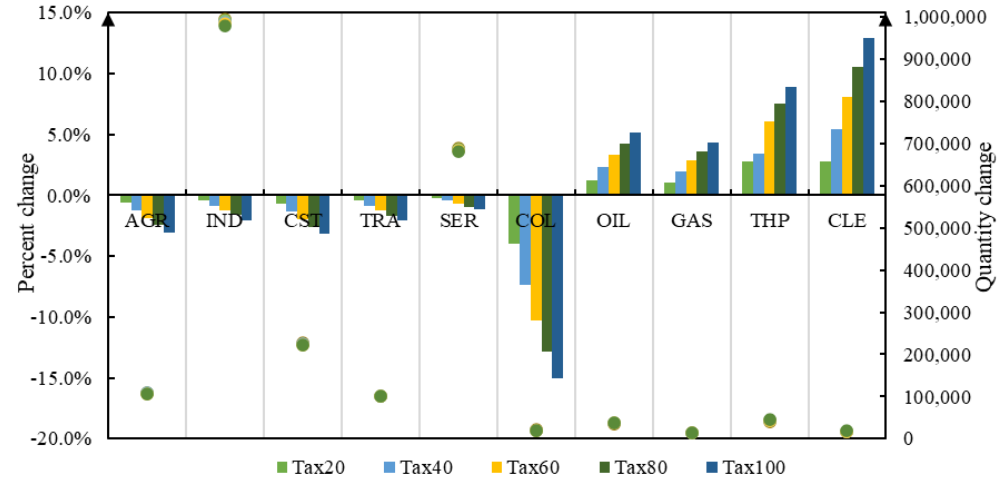
Figure 8. The variation of outputs of all sectors.